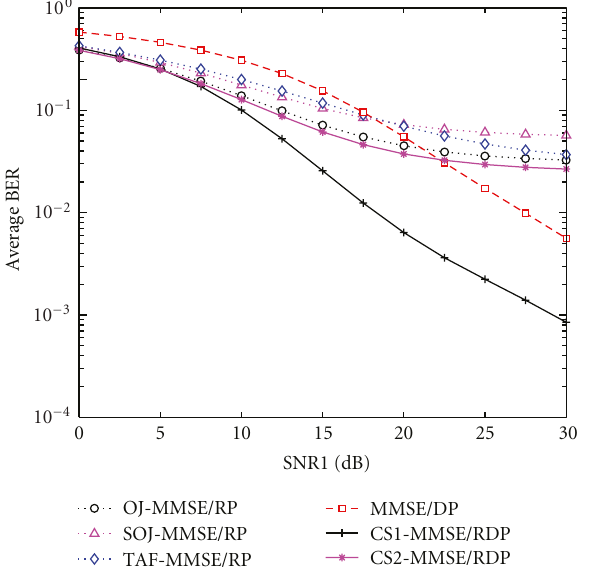
Figure 5: BER versus SNR of RS-BS link in uplink ( p = 0 . 4, SNR2 = 15dB) .